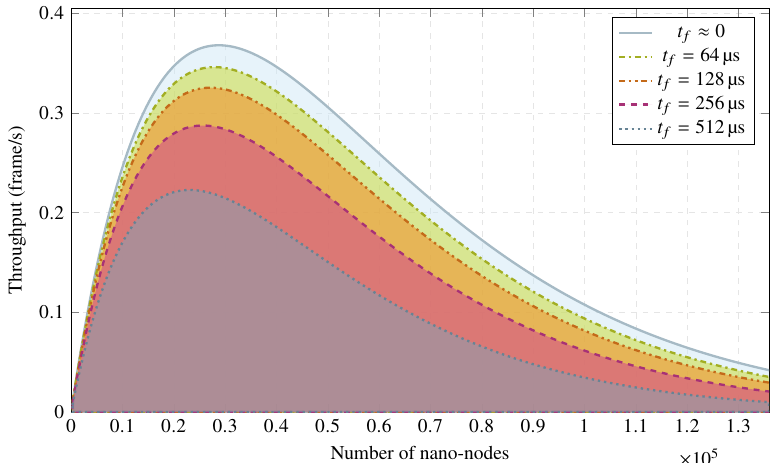
Figure 6. Network throughput for different frame lengths for A = 0.5 × 10 − 3 m, f = 1Hz, v = 0.24m / s, T = 60s, and σ = 1.